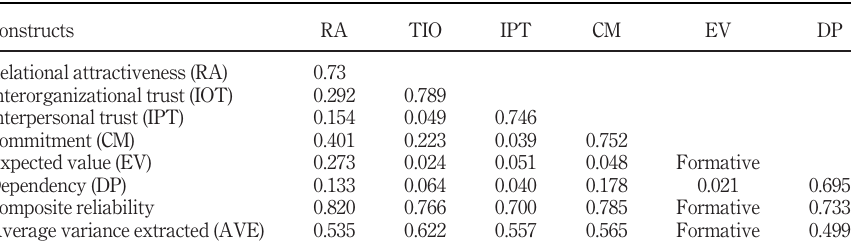
Table 2. Summary of the